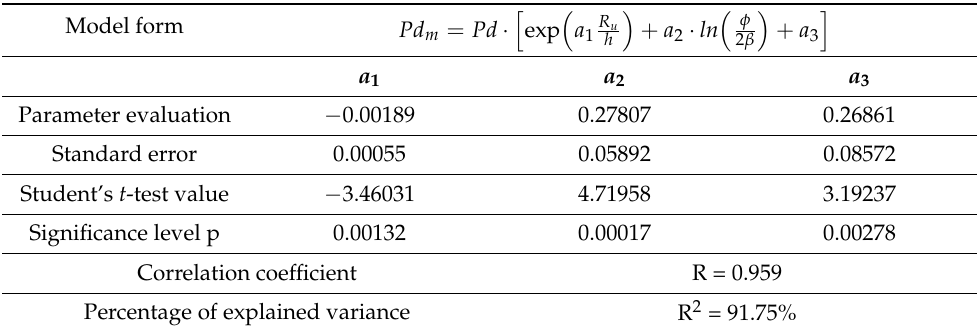
Table 2. Form of the model of the pressure force during mining without high-pressure assistance Pdm, together with the values of the estimated parameters [1]. Model